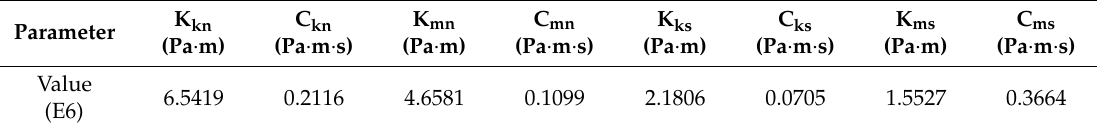
Table 8. Macro parameters of the Burgers model.